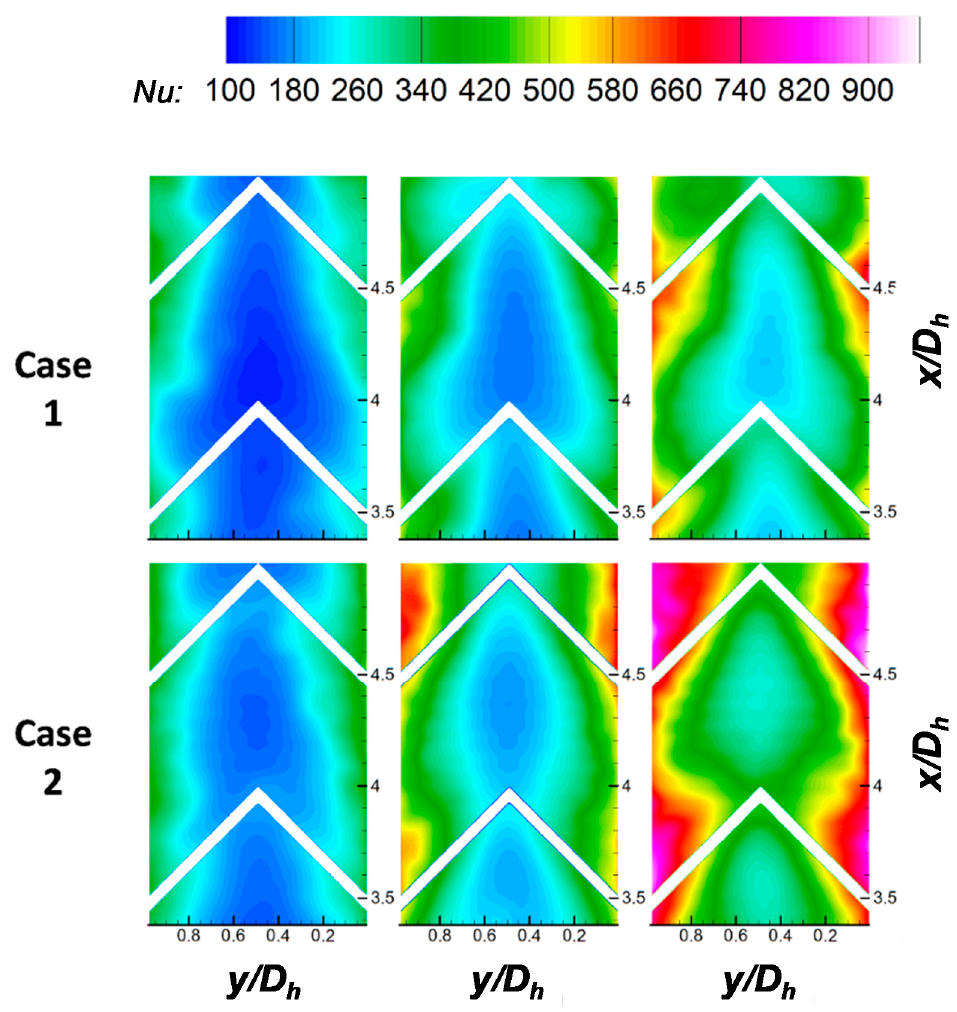
Figure 8. Nusselt number distribution of the mist flow on the V-shaped ribbed surface (P / e = 20). To improve the liquid film coverage, broken ribs with centerline drainage are proposed (Figure